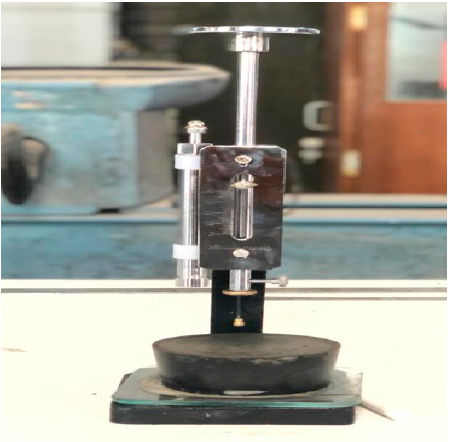
Figure 4. Vicat’s mould apparatus setup on setting test of cement paste.